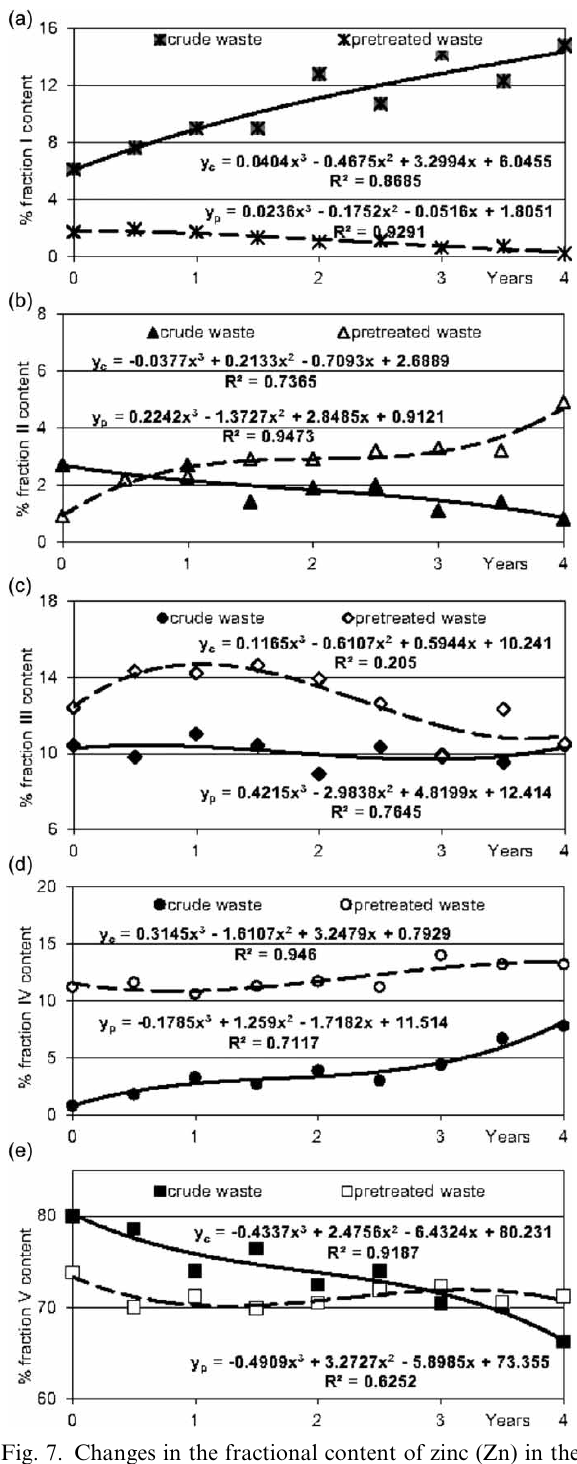
Fig. 7. Changes in the fractional content of zinc (Zn) in the surface layer of soil from the experimental plots irrigated and fertilized with mixed wastewaters from an oleo-chemical factory (cid:1) defatted raw (solid line of the trend (cid:1) y c ) and pretreated (broken line of the trend (cid:1) y p ) (C 0(Zn) (cid:1) 49.7 9 1.6 mg/kg d.m.). Individual fractions are given in diagrams: (a) fraction I (cid:1) exchanged, (b) fraction II (cid:1) carbonate, (c) fraction III (cid:1) connected with hydrated oxides of manganese and iron, (d) fraction IV (cid:1) organic, (e) fraction V (cid:1) the